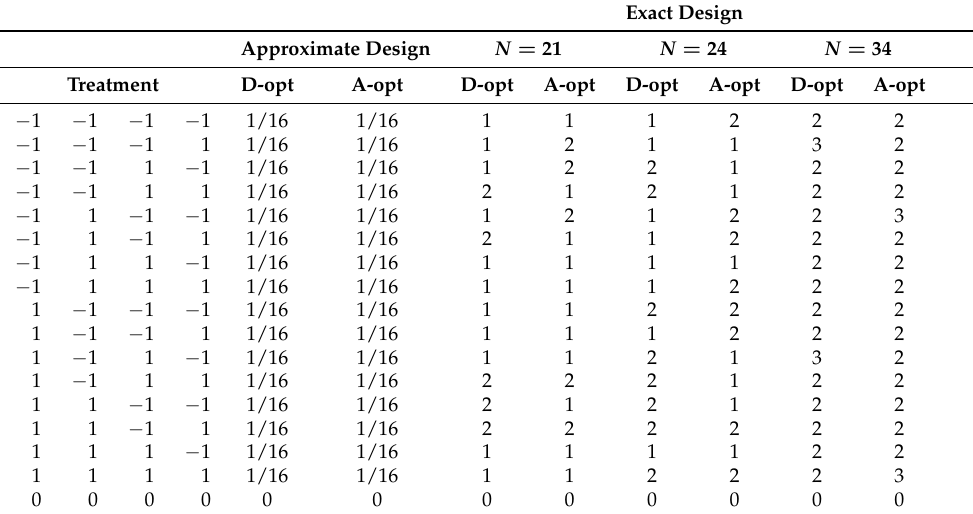
Table 4. D- and A-optimal designs for Model 3, where k = 17 and N = { 21,24,34 } .